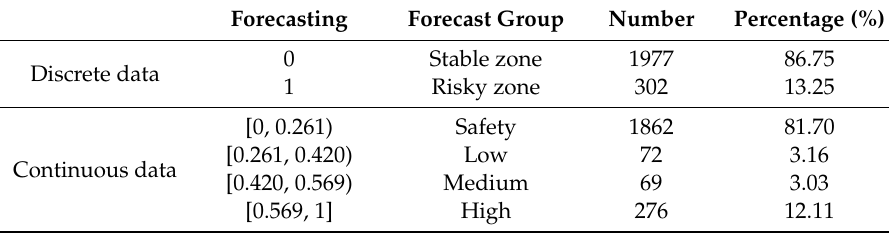
Table 5. Landslide susceptibility classification prediction